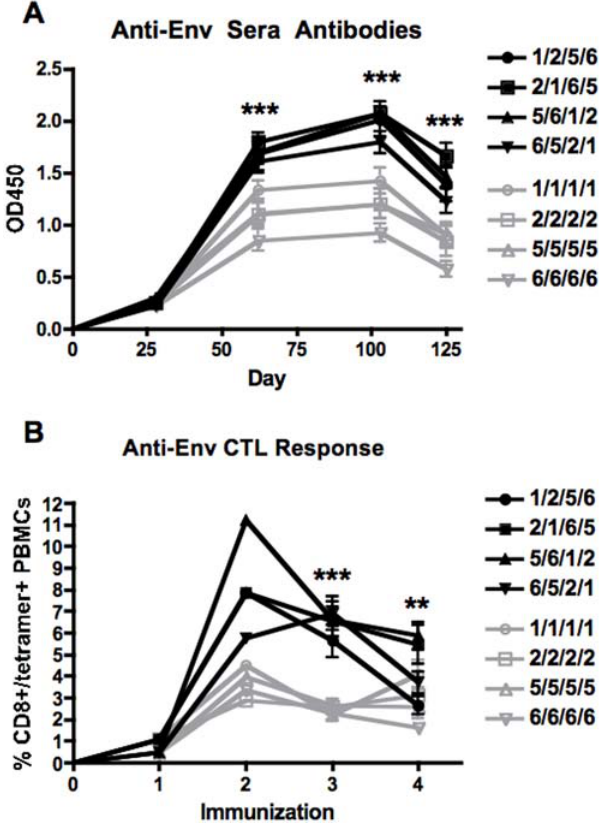
Figure 5. Anti-env humoral and cellular responses induced by HD-Ad serotypes. Groups of 20 BALB/c mice were immunized i.m. with 10 10 vp of HD-Ad vectors expressing the HIV-1 JRFL gp140 env. A) Sera antibodies were assayed by ELISA 4 wks after priming, prior to boosting and 3 wks after final boosting. B) Tetramer staining was perfomed 4 4 ks after priming, prior to boosting and 3 wks after final boosting. The percent CD8 + /tetramer + cells was determined by flow cytometry. Data is the mean activity from 20 mice for each group for priming and 10 mice for each group boosted. Error bars indicate standard error and the data were analyzed by two-way ANOVA (**=p , 0.01 and ***=p , 0.001).